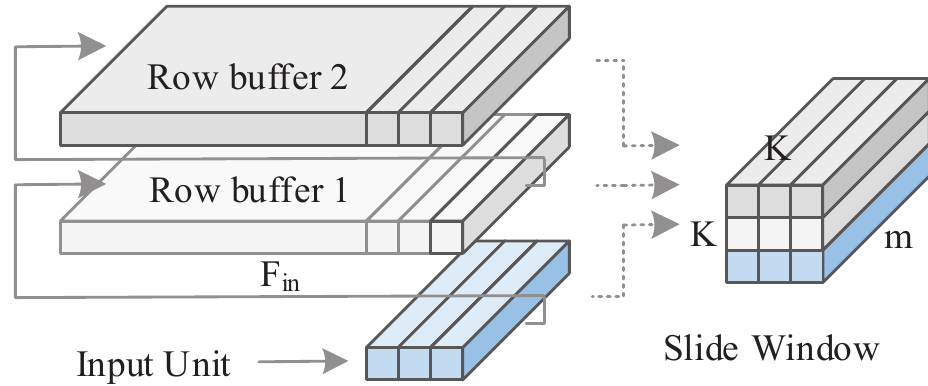
Figure 6. The line buffers for DWC with PUDL convolution